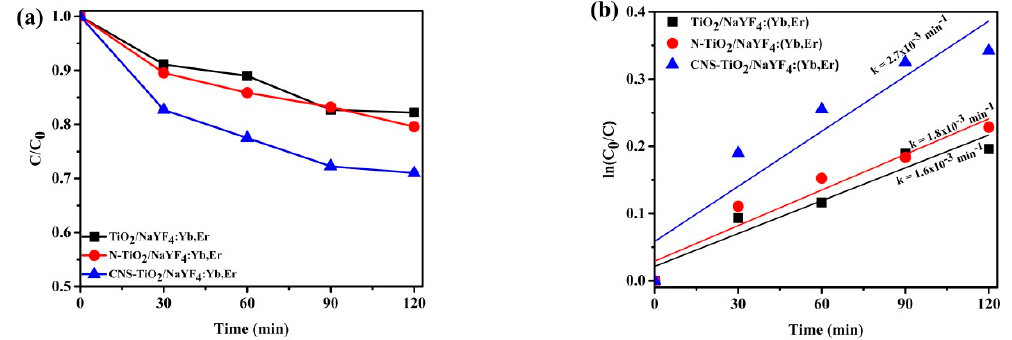
Figure 9. ( a ) MB peak absorbance against the NIR light activation time and ( b ) correlated rate of kinetics.